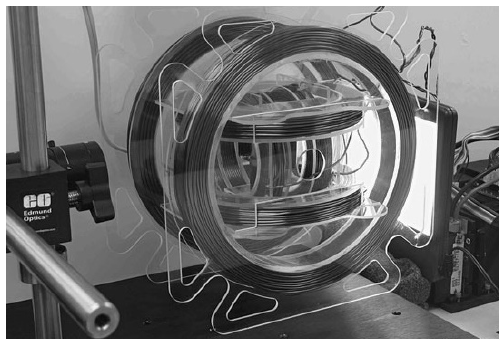
Figure 17. Photograph of the 3DH EMA setup developed by Mahoney et al.